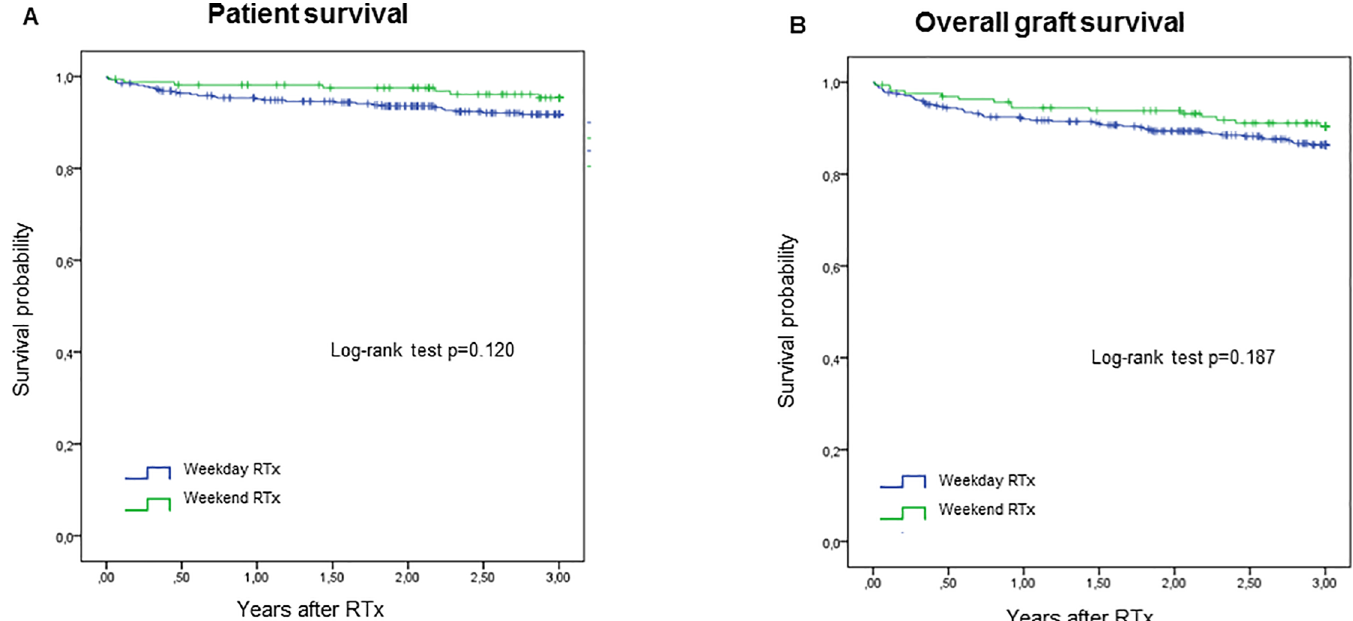
Fig 1. Kaplan-Meier curves for patient and overall graft survival. Patient survival (A) and overall graft survival (B) for weekdayand weekendkidney transplantations. Survival rates of weekday(blue lines) and weekend(green lines) kidney transplant recipients were estimated by Kaplan–Meier method and comparedby